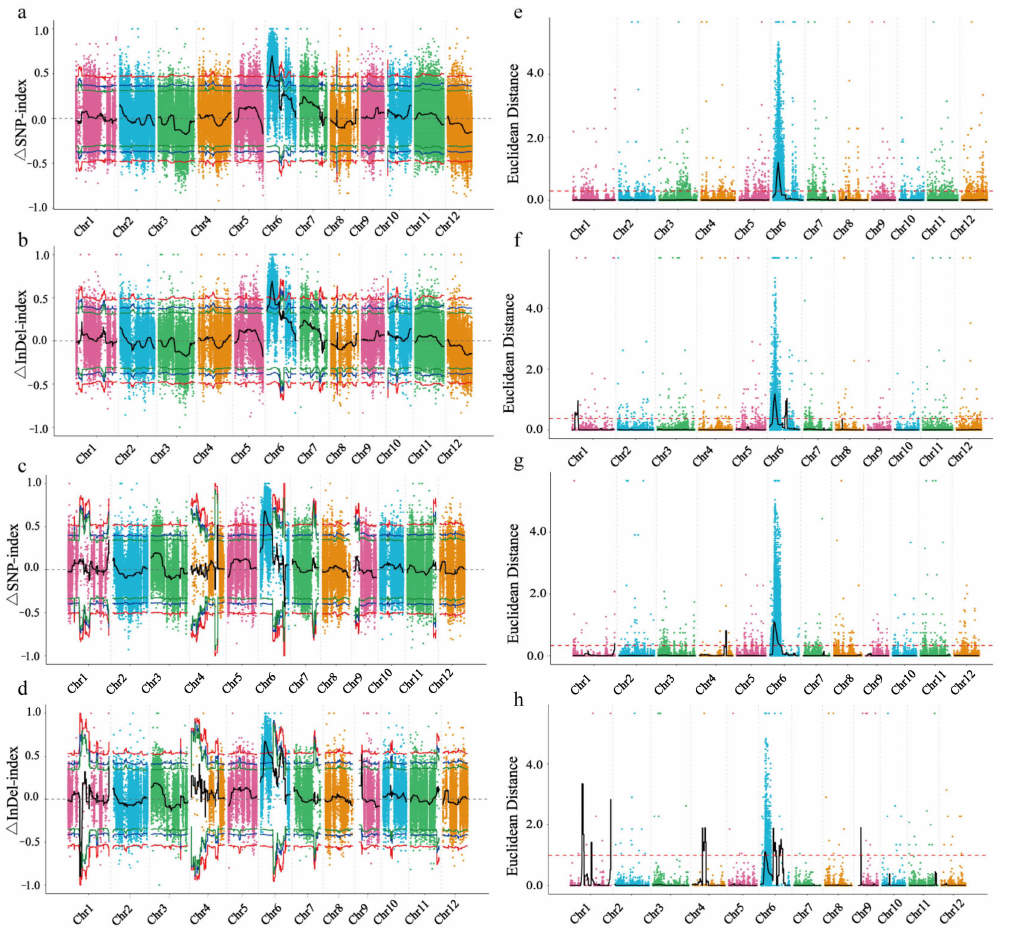
Figure 2. The ∆ All-index and ED are distributed on chromosomes of two populations. ( a ), Distribu- tion of ∆ SNP-index values of F2-1. ( b ), Distribution of ∆ InDel-index values of F2-1. ( c ), Distribution of ∆ SNP-index values of F2-2. ( d ), Distribution of ∆ InDel-index values of F2-2. ( e ), Distribution of ED-associated values of F2-1 by SNPs. ( f ), Distribution of ED-associated values of F2-1 by InDels. ( g ), Distribution of ED-associated values of F2-2 by SNPs. ( h ), Distribution of ED-associated values of F2-2 by InDels. ( a – d ), The colored dots represent the calculated ∆ All-index value, and the black lines represent the fitted ∆ All-index value; the red lines represent the threshold line with a confidence of 0.99, the blue lines represent the threshold line with a confidence of 0.95, and the green lines represent the threshold line with confidence of 0.90. ( e – h ), The colored points represent the ED value of each SNP or InDel, the black lines represent the fitted ED value, and the red dashed lines represent the significant correlation threshold. The higher the ED value, the better the correlation effect of this